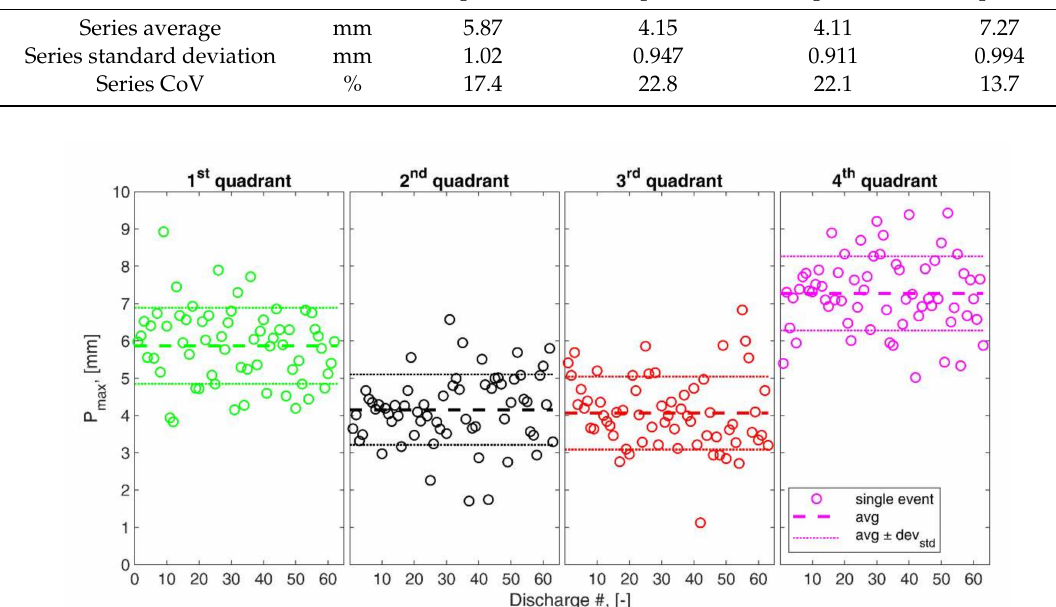
Figure 12. Details of max penetration distribution for the four quadrants over the 63 consecutive discharges. White-filled circles represent the single events, while dashed lines represent the series average value (avg) for each quadrant. Dotted lines represent the series standard deviation ( ± dev std ) from the corresponding average